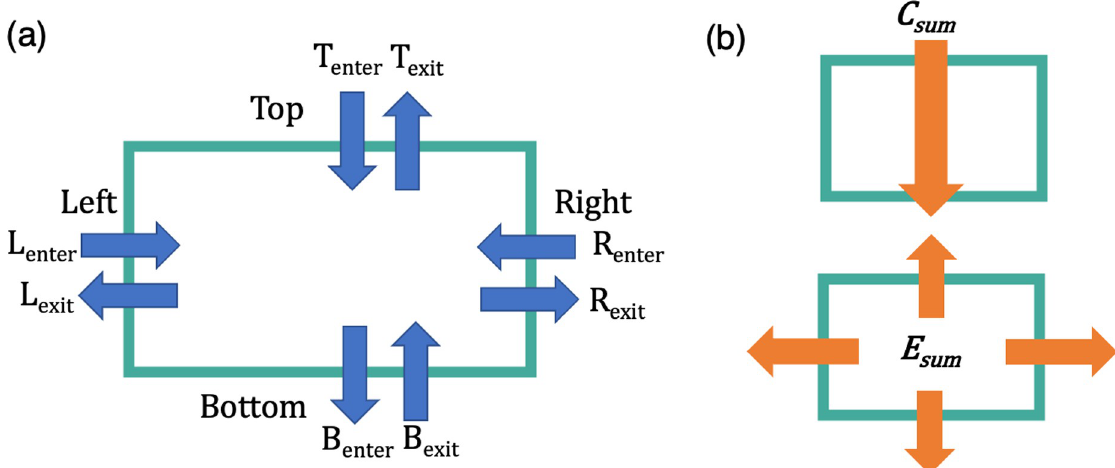
Fig 2. Illustration of the output summary results table based on the user selected region. This example shows the output for a rectangular box. (a) The software counts the total number of bats entering and exiting each side of the selection box for the entire video. (b) Illustration of the bat flight profiles that would be appropriate for using the Crossing sum, C The C sum should be used when counting bats transiting across the user selected region, whereas the E sum should be used when counting bats emerging from a central position within selected region.